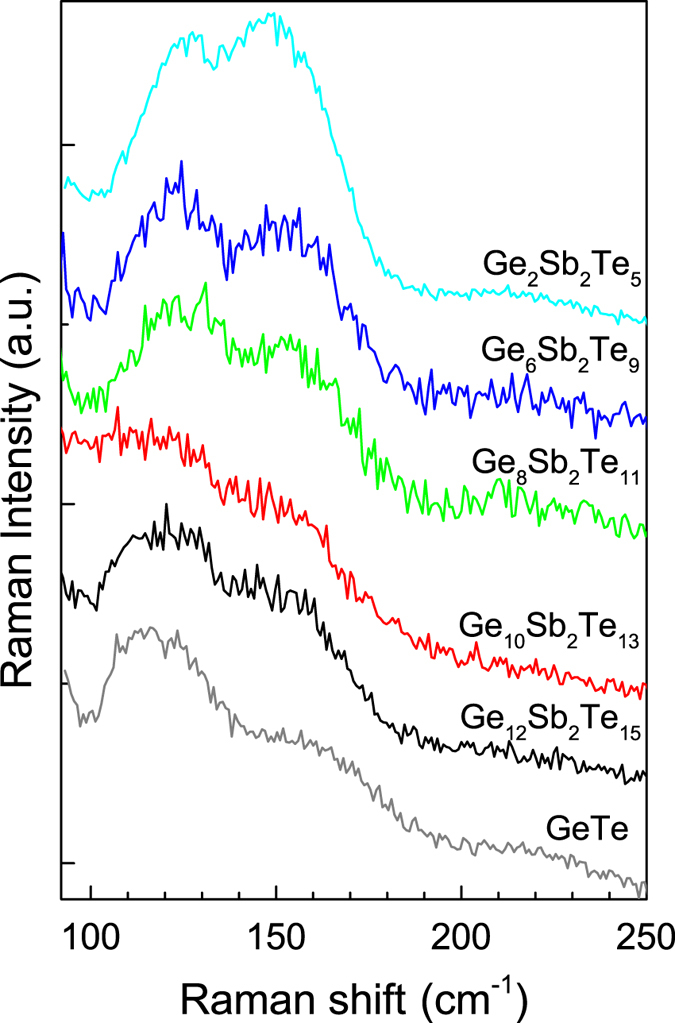
Raman scattering spectra of as-deposited amorphous PLD Ge6Sb2Te9 (blue), Ge8Sb2Te11 (green), Ge10Sb2Te13 (red), and Ge12Sb2Te15 (black) thin films.For a comparison, Raman data for amorphous GeTe (grey) and Ge2Sb2Te5 (cyan) PLD layers are shown.